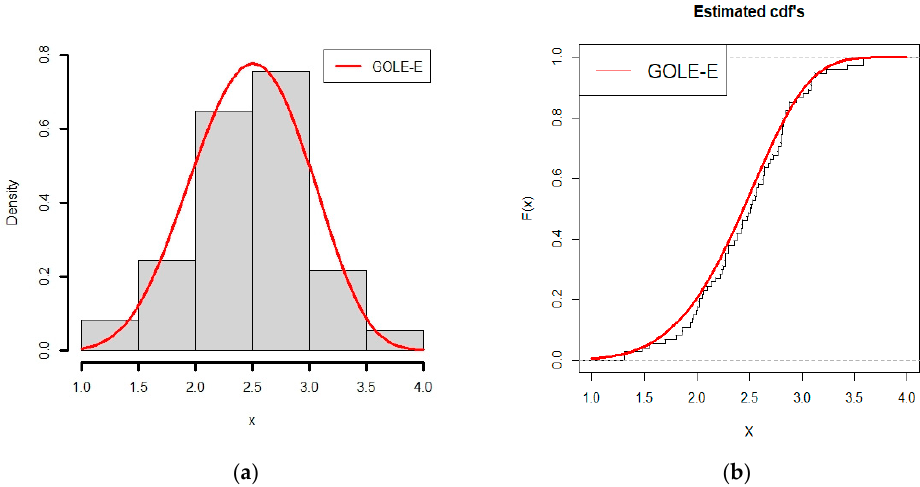
Figure 9. Plots of ( a ) the fitted PDF and ( b ) estimated CDF for the GOLE-E distribution for data set